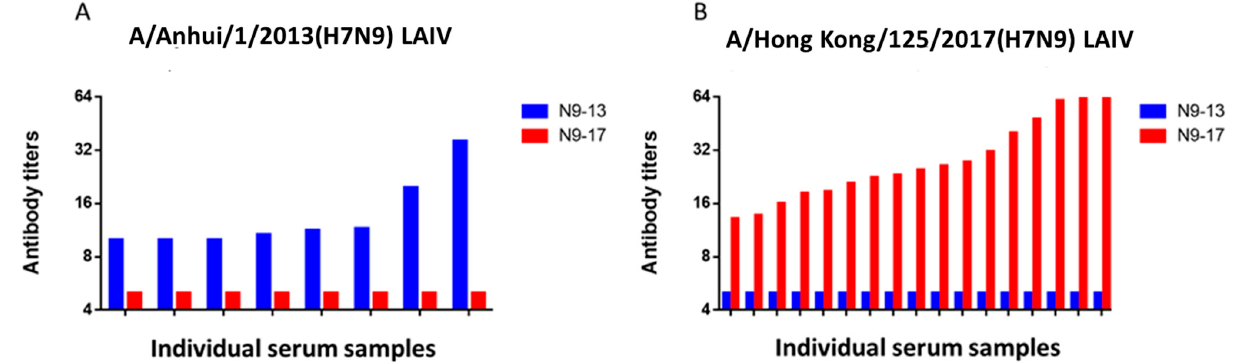
Figure 5. NI antibodies to antigenic variants of A/H7N9 after LAIV immunization. ( A ) Positive sera after A/Anhui/1/2013(H7N9)-based LAIV immunization ( n = 8). ( B ) Positive sera after A/Hong Kong/125/2017(H7N9)-based LAIV immunization ( n = 16).